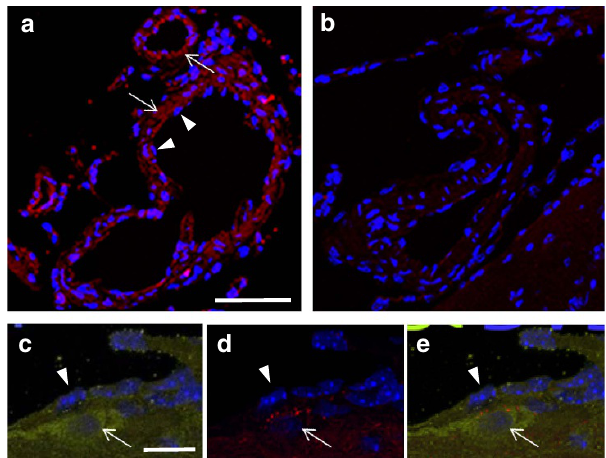
Figure 4 | HCAR1 immunoreactivity colocalizes with mRFP-HCAR1 at pial vessels. ( a , b ) HCAR1 immunoreactivity (red) is in the wall of blood vessels in pia mater (arrows), in wild-type ( a ), but not in knockout ( b ). Nuclei of endothelial cells (arrowheads) are on the luminal side of the immunoreactivity ( a ). Scale bar, 30 m m. ( c – e ) HCAR1 immunoreactivity (green, c , e ) is highly expressed in a leptomeningeal cell (arrow) on the abluminal side of the endothelium (arrowhead), which shows a slight HCAR1 immunoreactivity. In this reporter mouse, immunoreactivity to mRFP-HCAR1 (red, d , e ) is seen in cytoplasmic granules in the leptomeningeal cell. Nuclei are blue (DAPI). All sections are from paraffin-embedded brain tissue and exposed to heat-induced epitope retrieval. Scale bars, ( a , b ), 30 m m; ( c – e ), 10 m m.